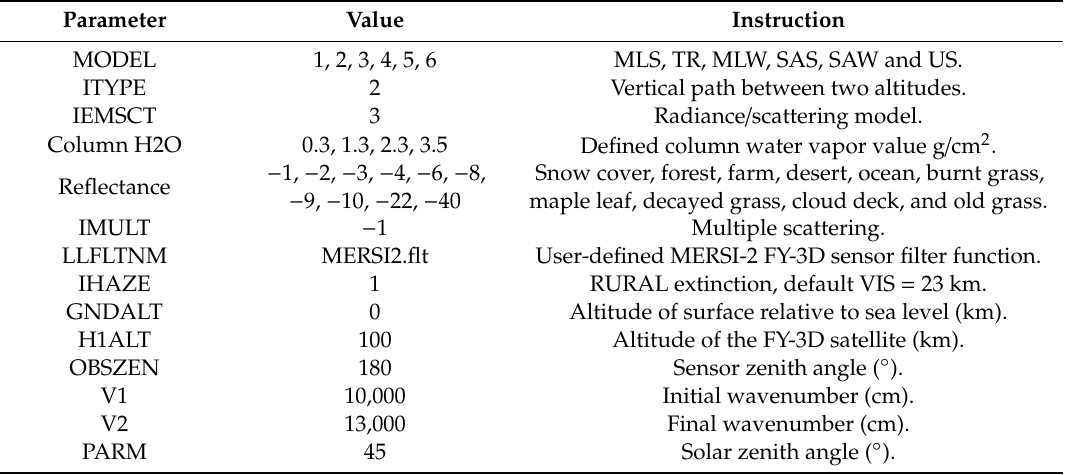
Table 2. The arrangement of important parameters configured to run MODTRAN 5 radiative transfer code for the simulation of the synthetic dataset.